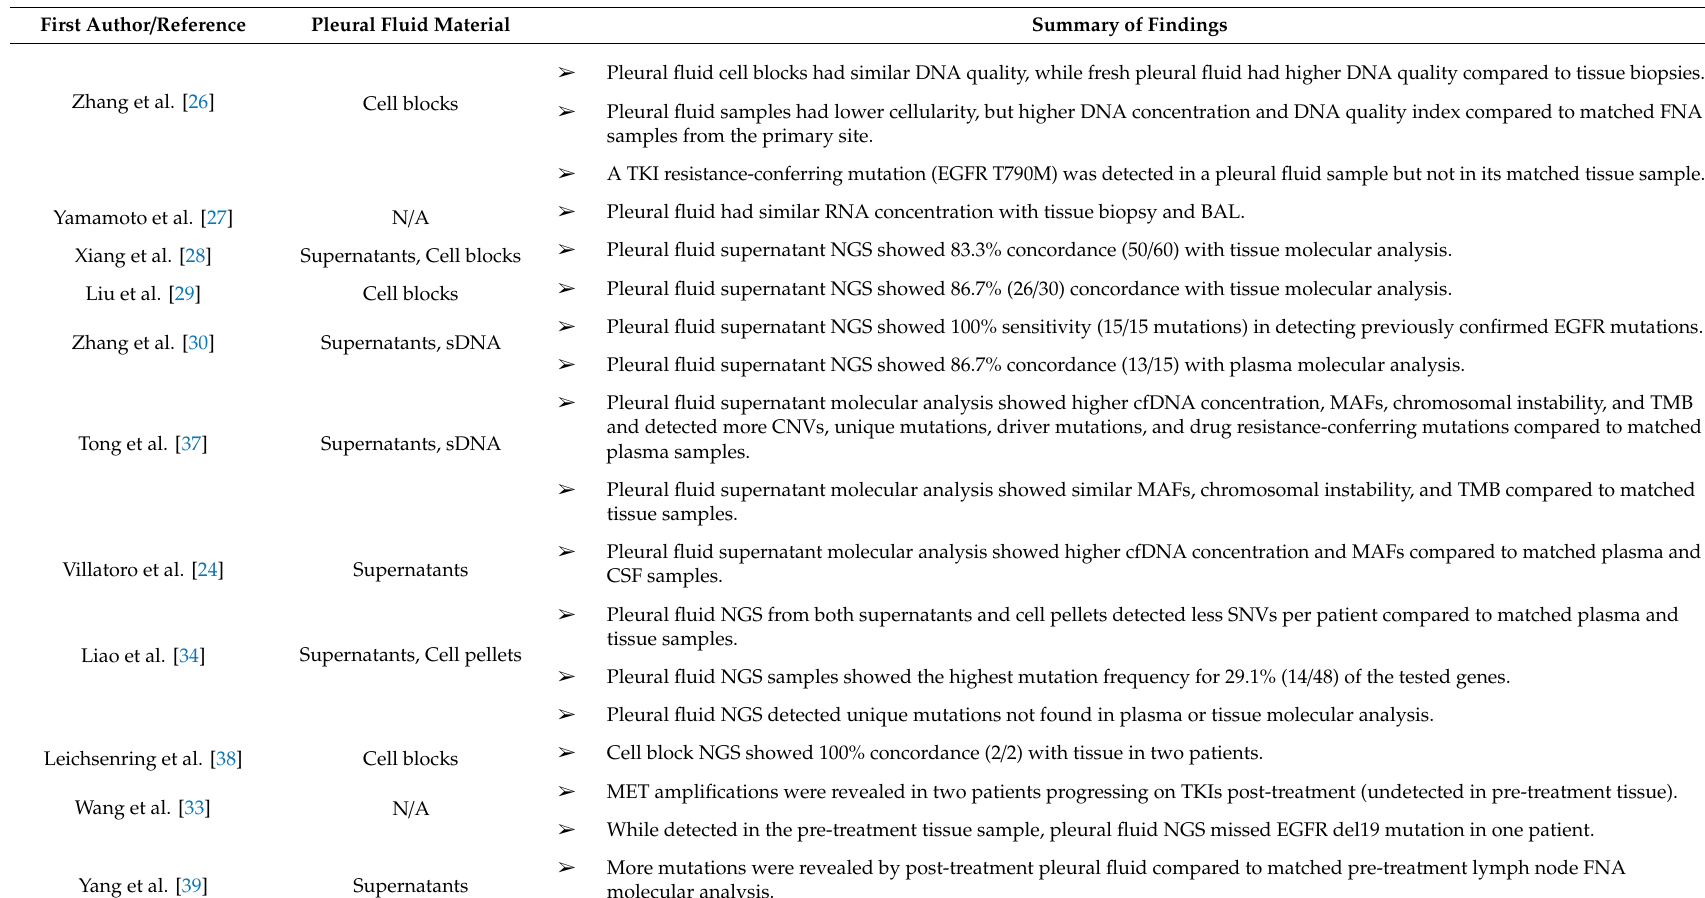
Table 1. NGS analysis of NSCLC pleural fluid liquid biopsy samples compared with tissue biopsies and FNA, plasma, CSF, and BAL